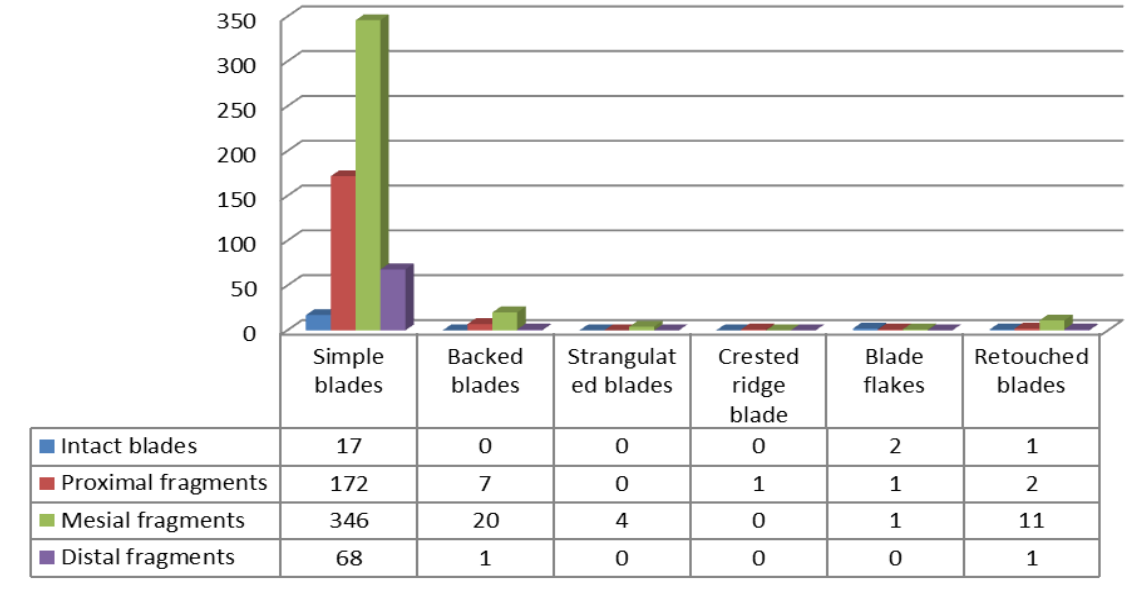
Table 1: metric comparison of Rohri chert blades Rohri chert blades No. Mean Median Mode Std dev Intact blades 20 Length Proximally broken 183 blades Mesial blades 382 Distally broken blades